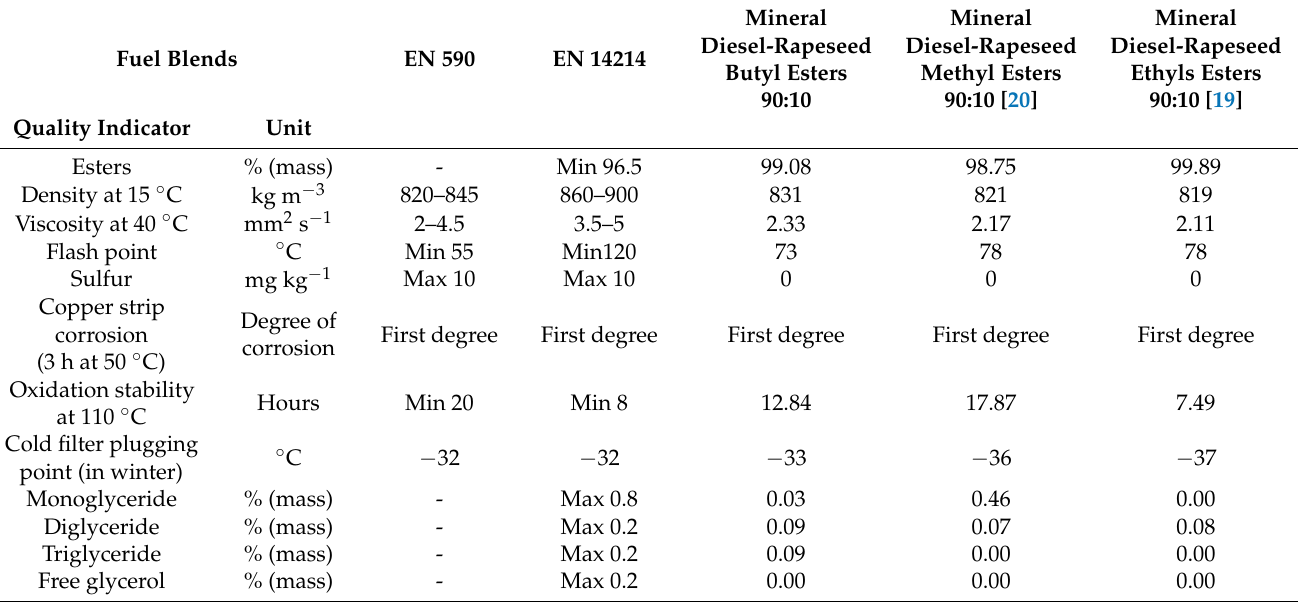
Table 5. Quality indicators of fuel